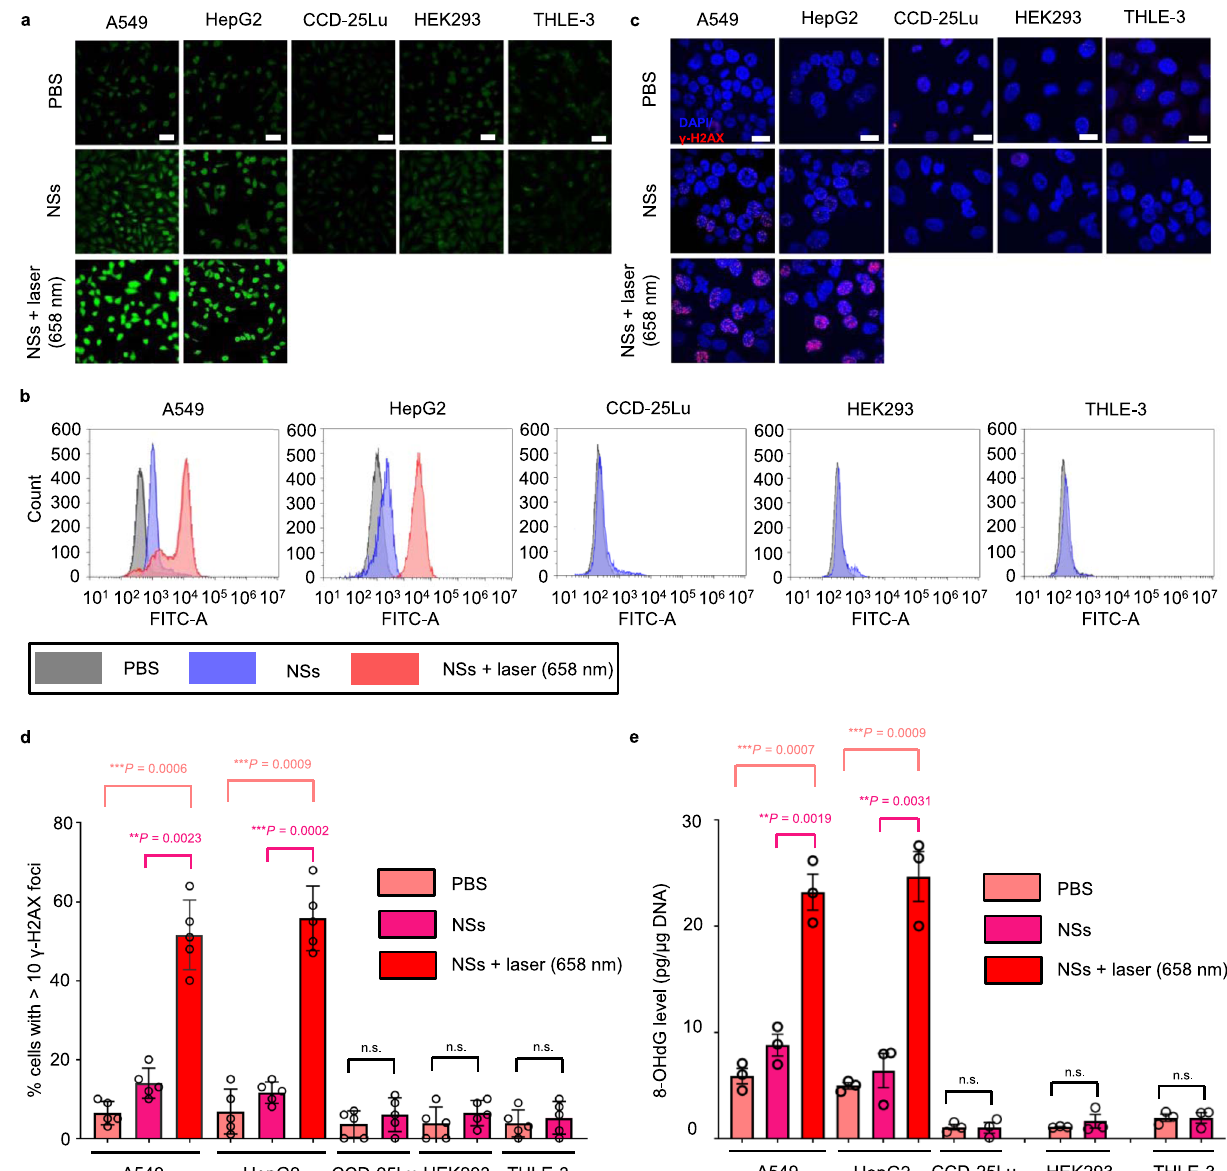
Fig. 8 In vitro toxicity. a Representative confocal microscopy images (three times each experiment was repeated independently with similar results) and b fl ow cytometry detection of ROS contents from the different cancer cell lines and normal cell lines (scale bars, 50 μ m) after different treatments (irradiation was performed only on cancer cells). c Representative confocal microscopy images of the different cancer cell lines and normal cell lines (scale bars, 50 μ m) after different treatments. The nuclei were stained by DAPI (blue), and the γ H2AX foci per nucleus were stained by anti- γ H2AX antibody (red). Five times each experiment was repeated independently with similar results. d Quanti fi cation of the percentages of cells with >10 γ H2AX foci numbers by confocal microscopy. The data show mean ± s.d., n = 5 biologically independent cells, and signi fi cance was determined using a two-tailed t -test (** P < 0.01, *** P < 0.001). e In vitro DNA damage of the cells after different treatments were measured by 8-OHdG assay. The data show mean ± s.d., n = 3 biologically independent cells, and signi fi cance was determined using a two-tailed t -test (** P < 0.01, *** P <